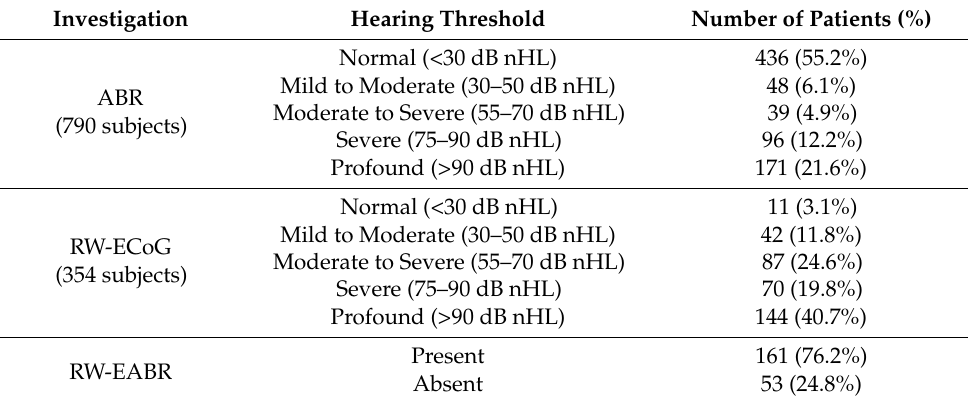
Table 1. Assessment of hearing thresholds with ABR, RW-ECoG, and RW-EABR.